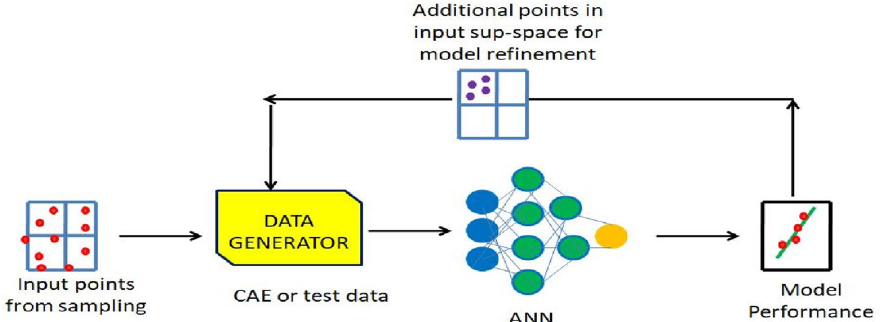
Fig. 1 Process of developing an ANN surrogate model